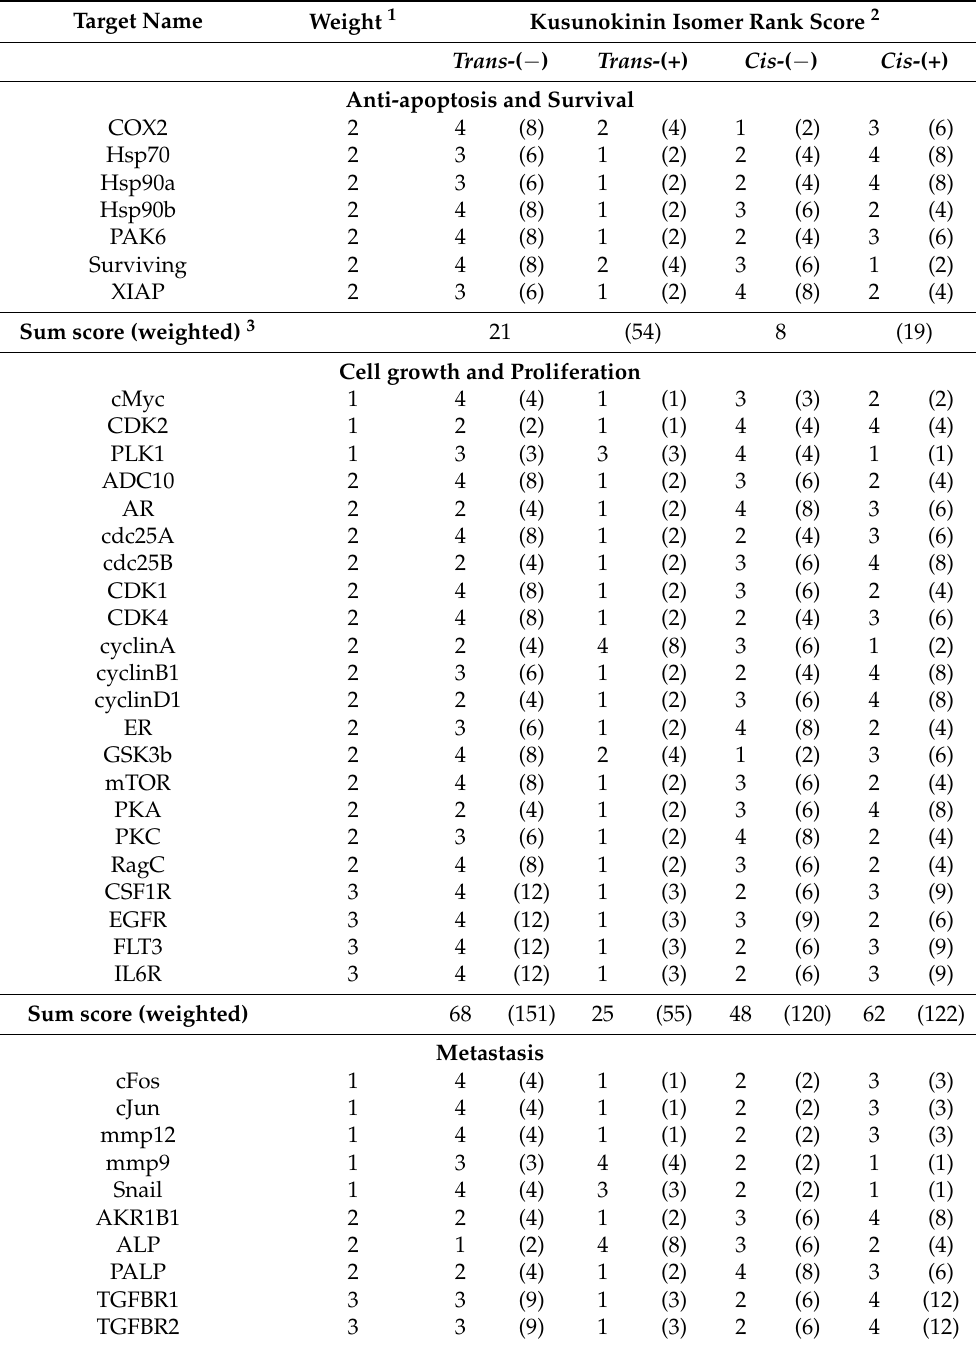
Table 2. Candidate proteins with rank score and weight